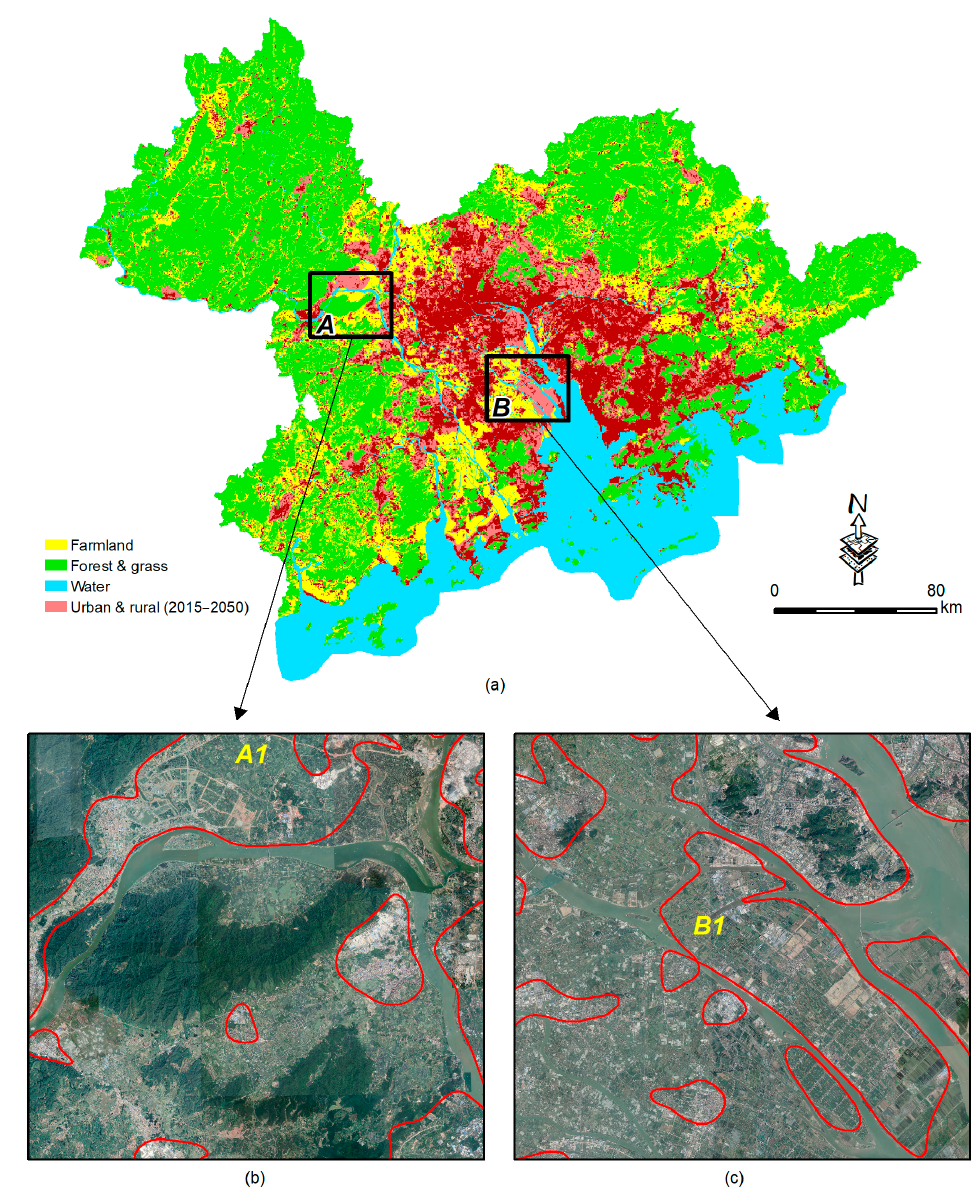
Figure 5. Analysis of the feasibility of simulation results for urban growth in China’s GBA using high ‐ resolution remote sensing images.